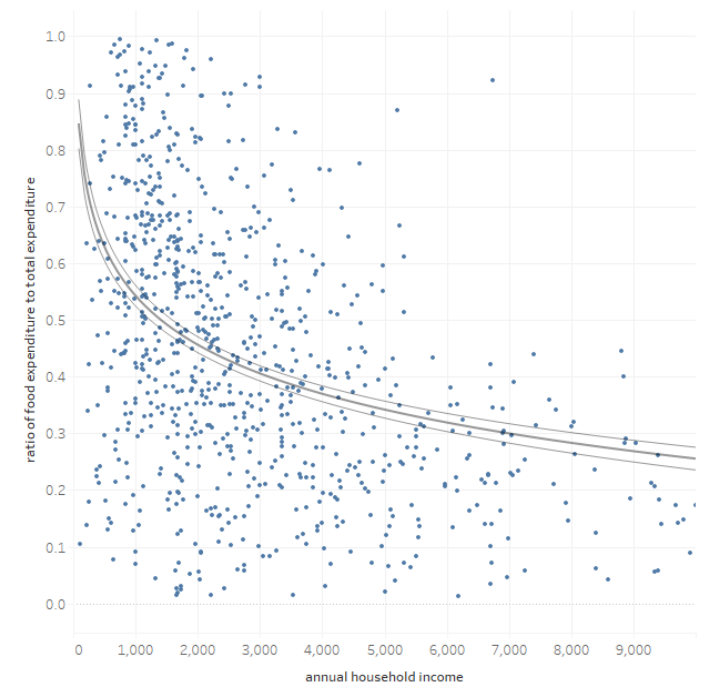
Figure 2. Relationship between annual household income and ratio of food expenditure to total household